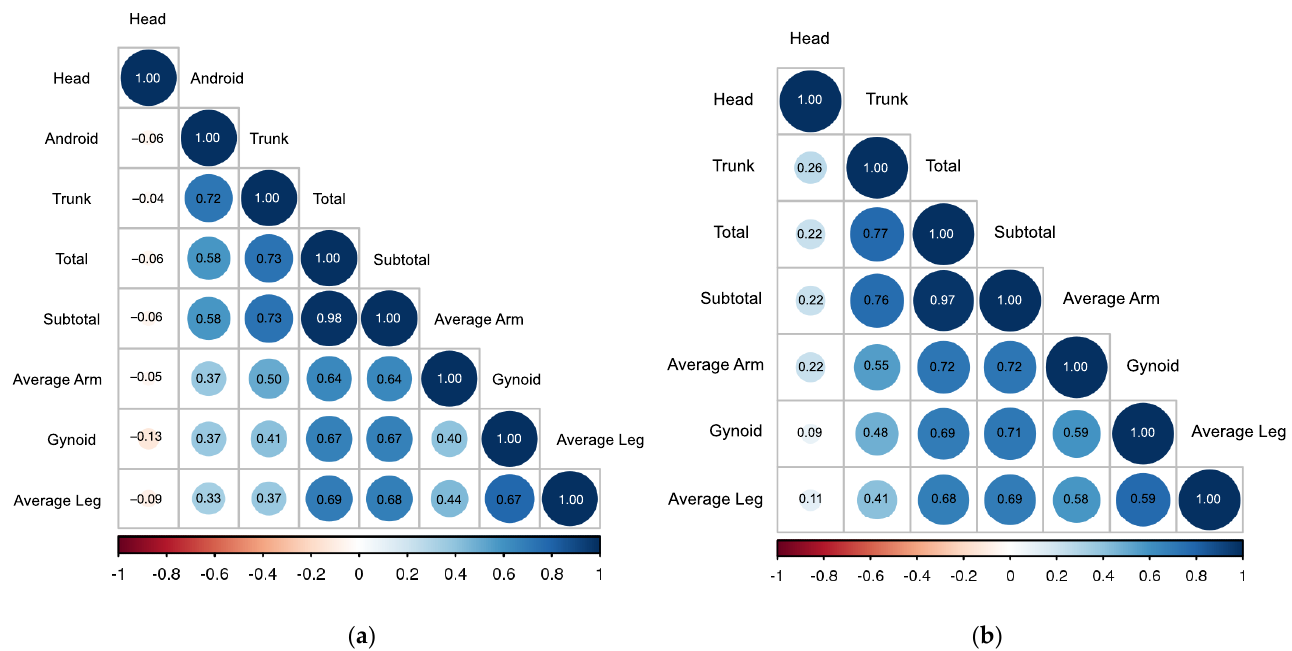
Figure 1. Correlation matrix of Fat Distribution in Non-obese ( a ) Female NAFLD ( b ) Male NAFLD. A multivariate logistic regression analysis adjusted for age, race, BMI, and diabetic Table 2. Correlations between Regional Body Fat Measures in Non-obese Males and Females. status clustered on the study year was used to examine the risk of NAFLD and body fat distribution in non-obese (Figure 2) and obese (Figure 3) populations. In both populations, all quartiles of body fat percentages were significantly ( p < 0.001) and positively associated with an increased risk of NAFLD. With reference to Q1 of body fat distribution, NAFLD risk increased with higher body fat percentages from Q2 to Q4, where each standard de- viation increment in all regional measurements was positively associated with NAFLD risk. In the non-obese population, Q4 of total, subtotal, trunk, android, and average arm fat percentages were associated with significant odds of NAFLD development compared with Q1. Greater percentages of leg (OR: 3.19, 95%CI: 1.85 – 5.49, p < 0.001) and gynoid (OR: 3.83, 95%CI: 1.90 – 7.73, p < 0.001) fat showed the smallest magnitudes of effect in non-obese individuals, albeit being significantly associated with increased risk of NAFLD.